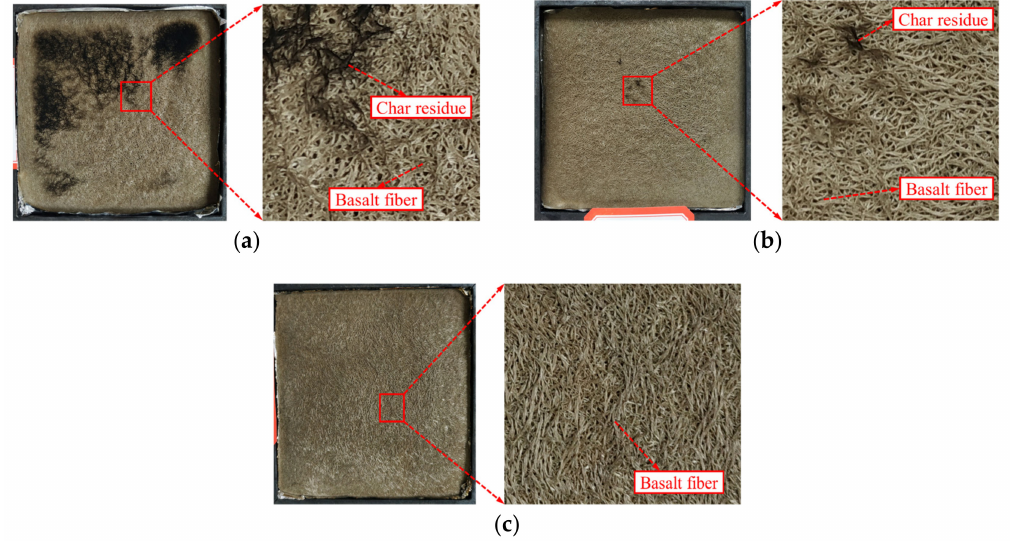
Figure 17. Photos of BFRPP sample after cone calorimeter test (CCT): ( a ) 25 kW · m − 2 ; ( b ) 35 kW · m − 2 ; and ( c ) 50 kW · m − 2